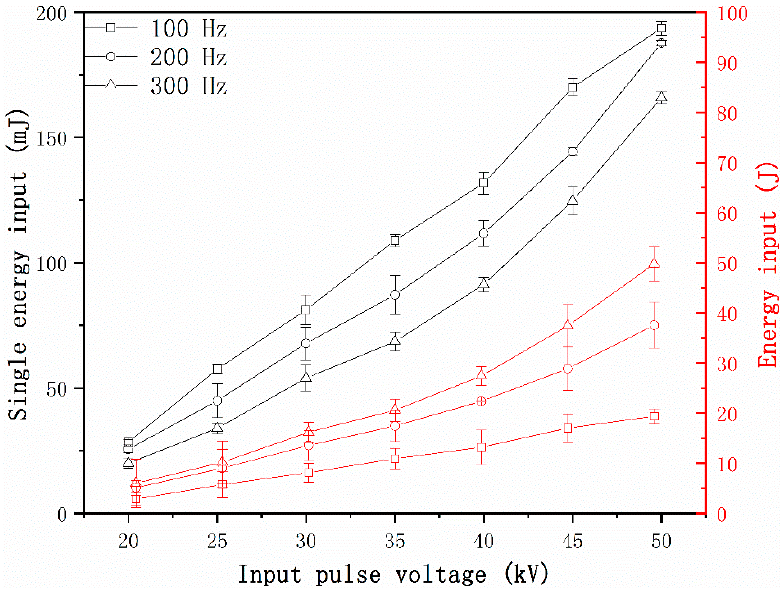
Figure 11. Pulse energy input at different pulse voltages and pulse frequencies.